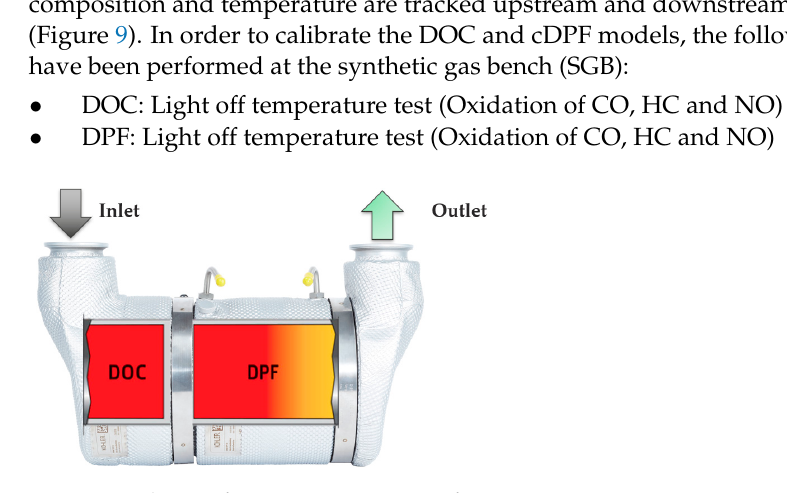
Table 6. Characteristics of reactor scale DOC sample and DOC full-size catalyst.